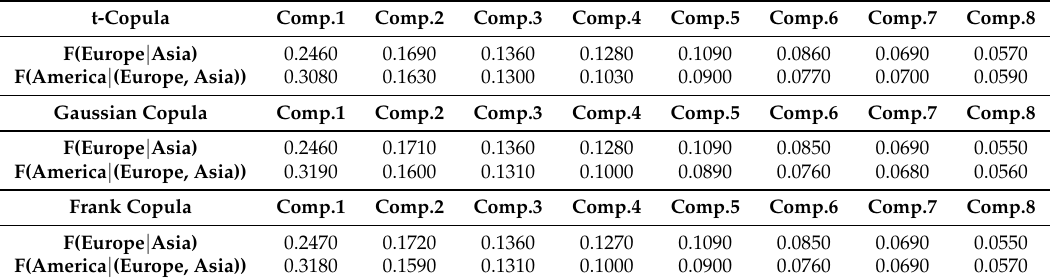
Table 13. PCA variance proportions with copulas of real data (1/3/2013 to 10/6/2014).